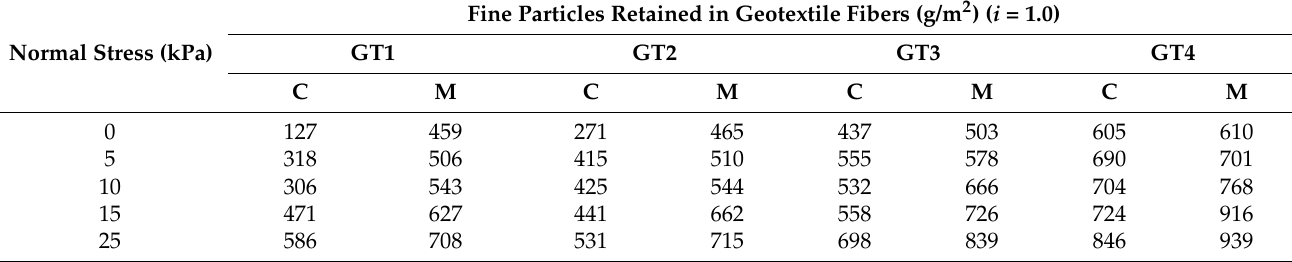
Table 5. Mass of fine particles retained inside the geotextile fibers after the entire filtration test at 48 h. Fine Particles Retained in Geotextile Fibers (g/m 2 ) ( i = 1.0) Normal Stress (kPa)